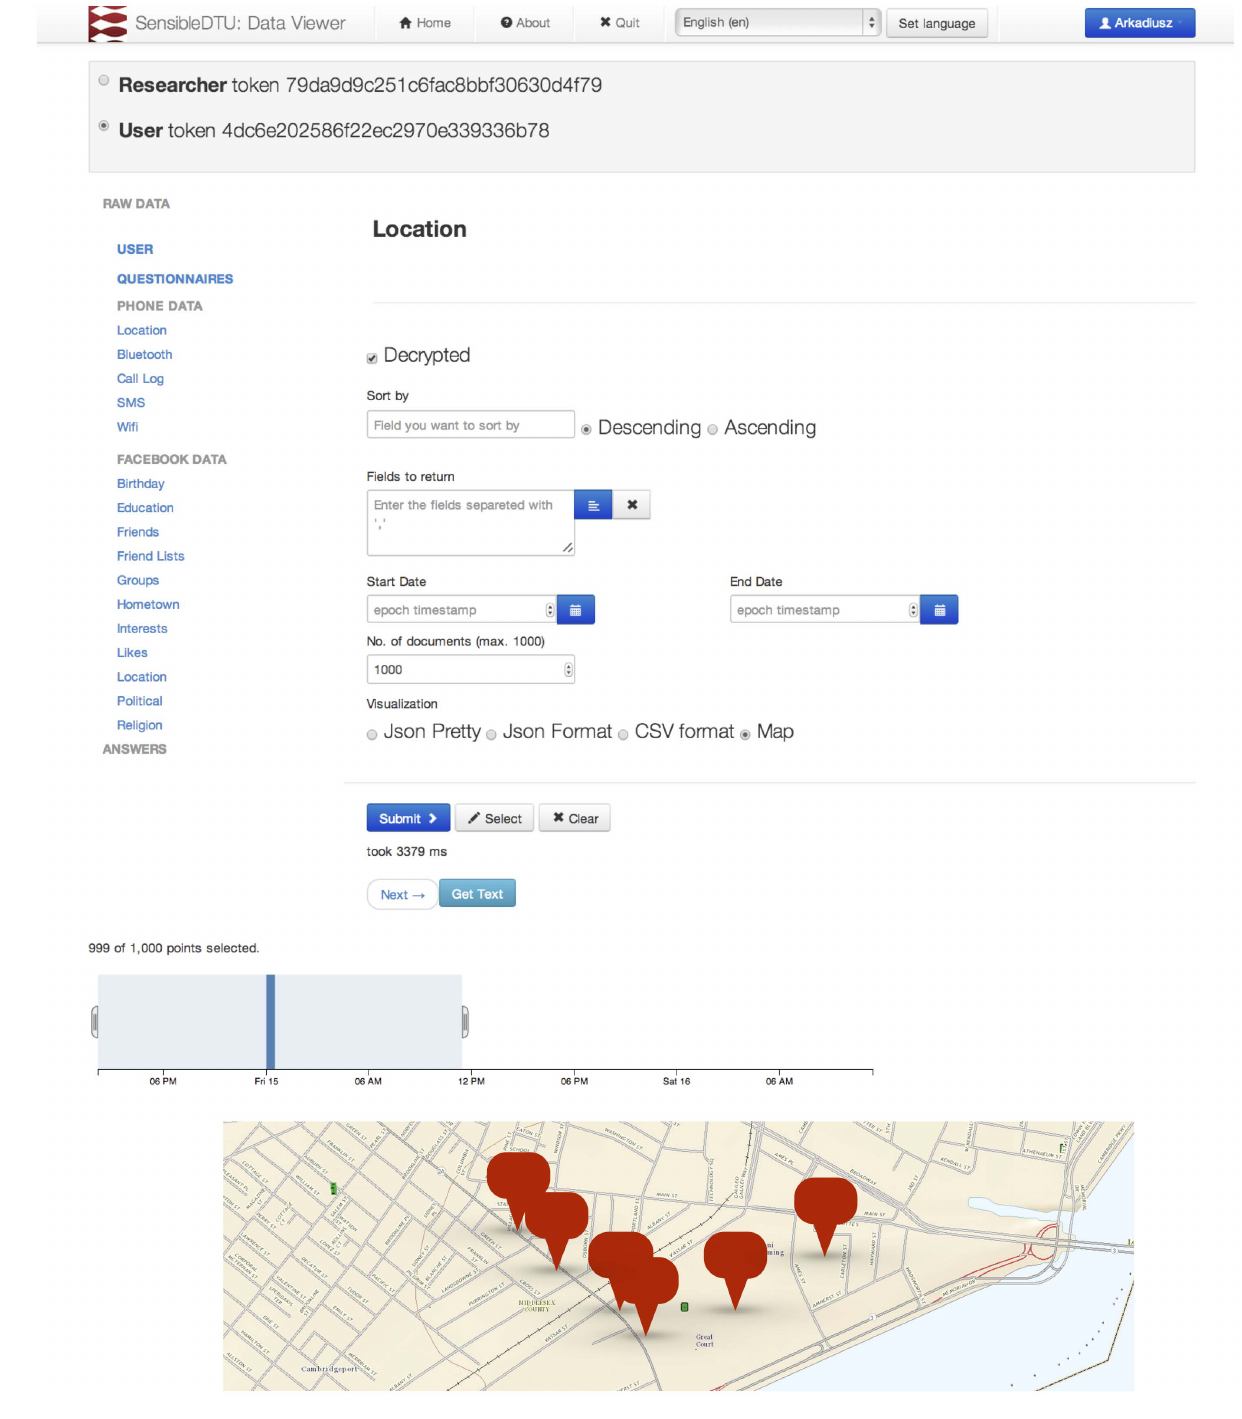
Figure 4. Data viewer application. All the collected data can be explored and accessed via an API. The API is the same for research, application, and end-user access, the endpoints are protected by OAuth2 bearer token. Map image from USGS National Map Viewer, replacing original image used in the deployed application (Google Maps). doi:10.1371/journal.pone.0095978.g004 Bluetooth and Social Ties Bluetooth is a wireless technology ubiquitous in modern-day mobile devices. It is used for short-range communication between devices, including smartphones, hands-free headsets, tablets, and other wearables. As the transmitters used in mobile devices are